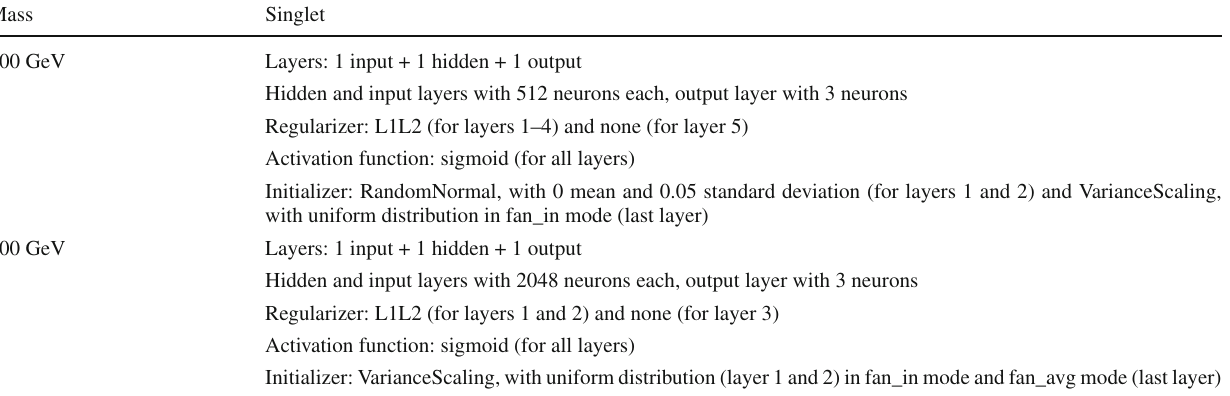
Table 10 Architectures for the neural networks that the genetic algorithm finds for the scanned masses (100 and 200 GeV) of the singlet VLL scenario